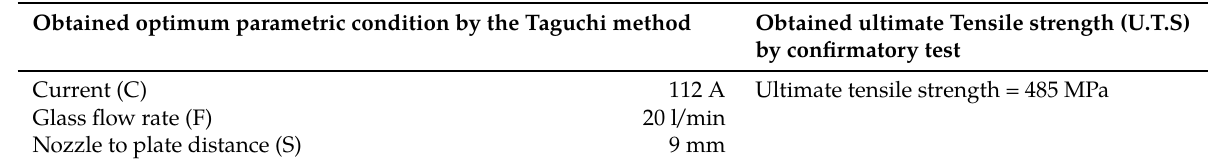
Table 7: Confirmatory